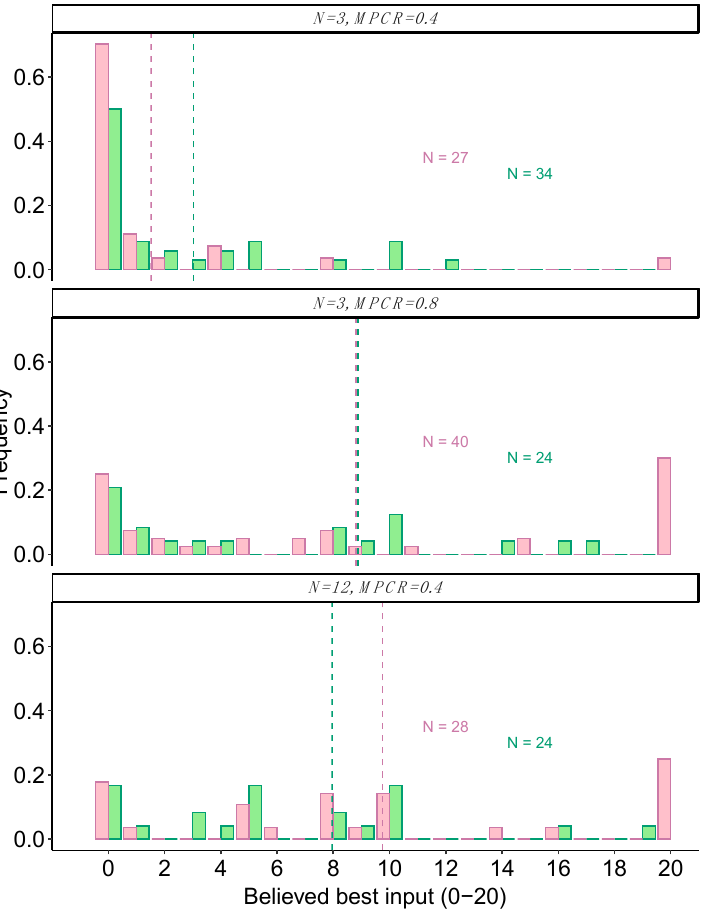
Figure 3. Groupmates and beliefs. Histograms show the frequency of each stated belief about what was the best number to input into the black box. Dashed vertical lines show the mean response. All responses are from naïve participants after finishing their first black box. The figures are annotated with the number of individuals. Table 3. Beliefs about the best number. The mean ±SE value participants stated as the best number to input at the end of the game. Comparisons made with Wilcoxon rank-sum test.